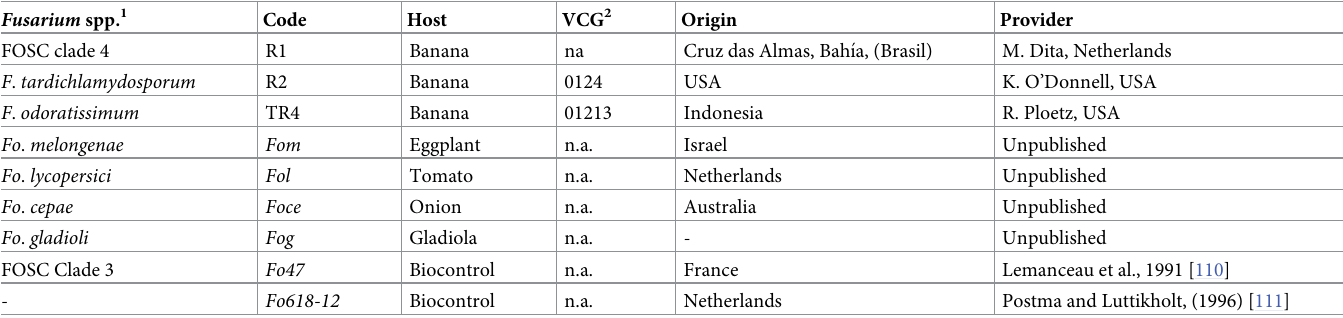
Table 1. Origins and characteristics of the Fusarium spp. strains used in this study. Fusarium spp.